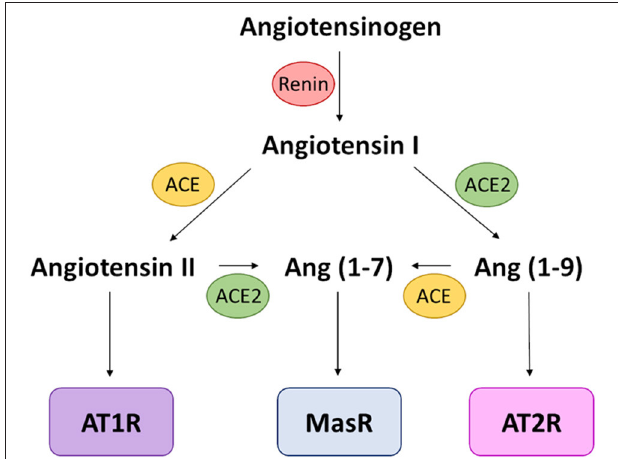
FIGURE 3 | RAAS schematic. Simplified schematic focusing on the activity of ACE and ACE2 and the resulting receptor activation. The vasoconstrictive activity of this pathway is mediated by AT 1 R activation, which also causes increased oxidative stress; MasR and AT 2 R activation leads to vasodilation and a reduction in oxidative stress. Receptors are in boxes; enzymes that processes signalling peptides are in ovals.